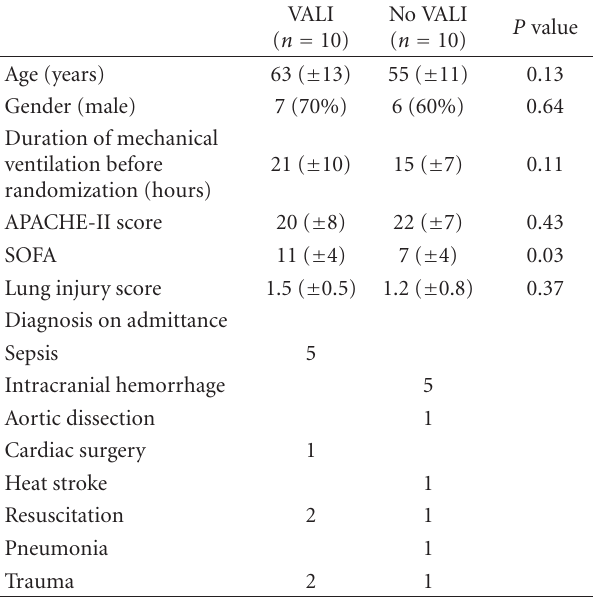
Table 1: Baseline